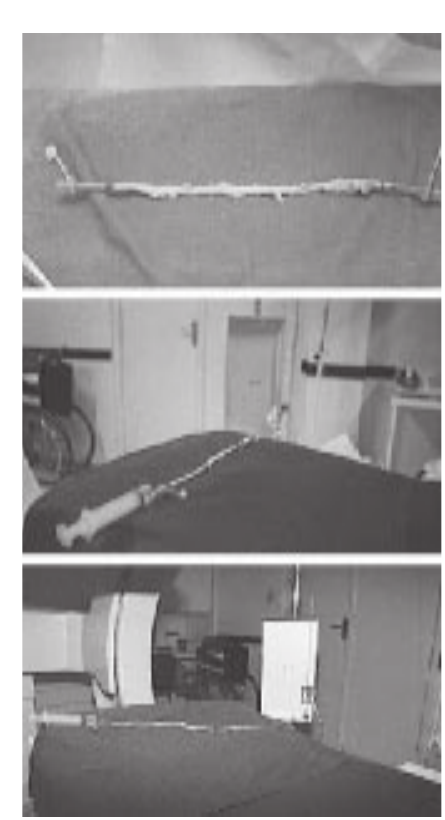
Fig. 2 - Preparo para arteriografia. Posicionamento da artéria radial para injeção de contraste.